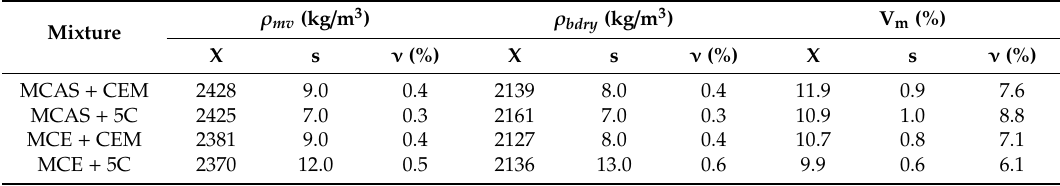
Table 5. Results of tests of physical properties of the MCAS / MCE cold-recycled mixture. Mixture